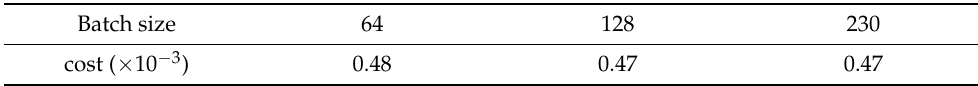
Table 5. The cost performance on NEU with different batch